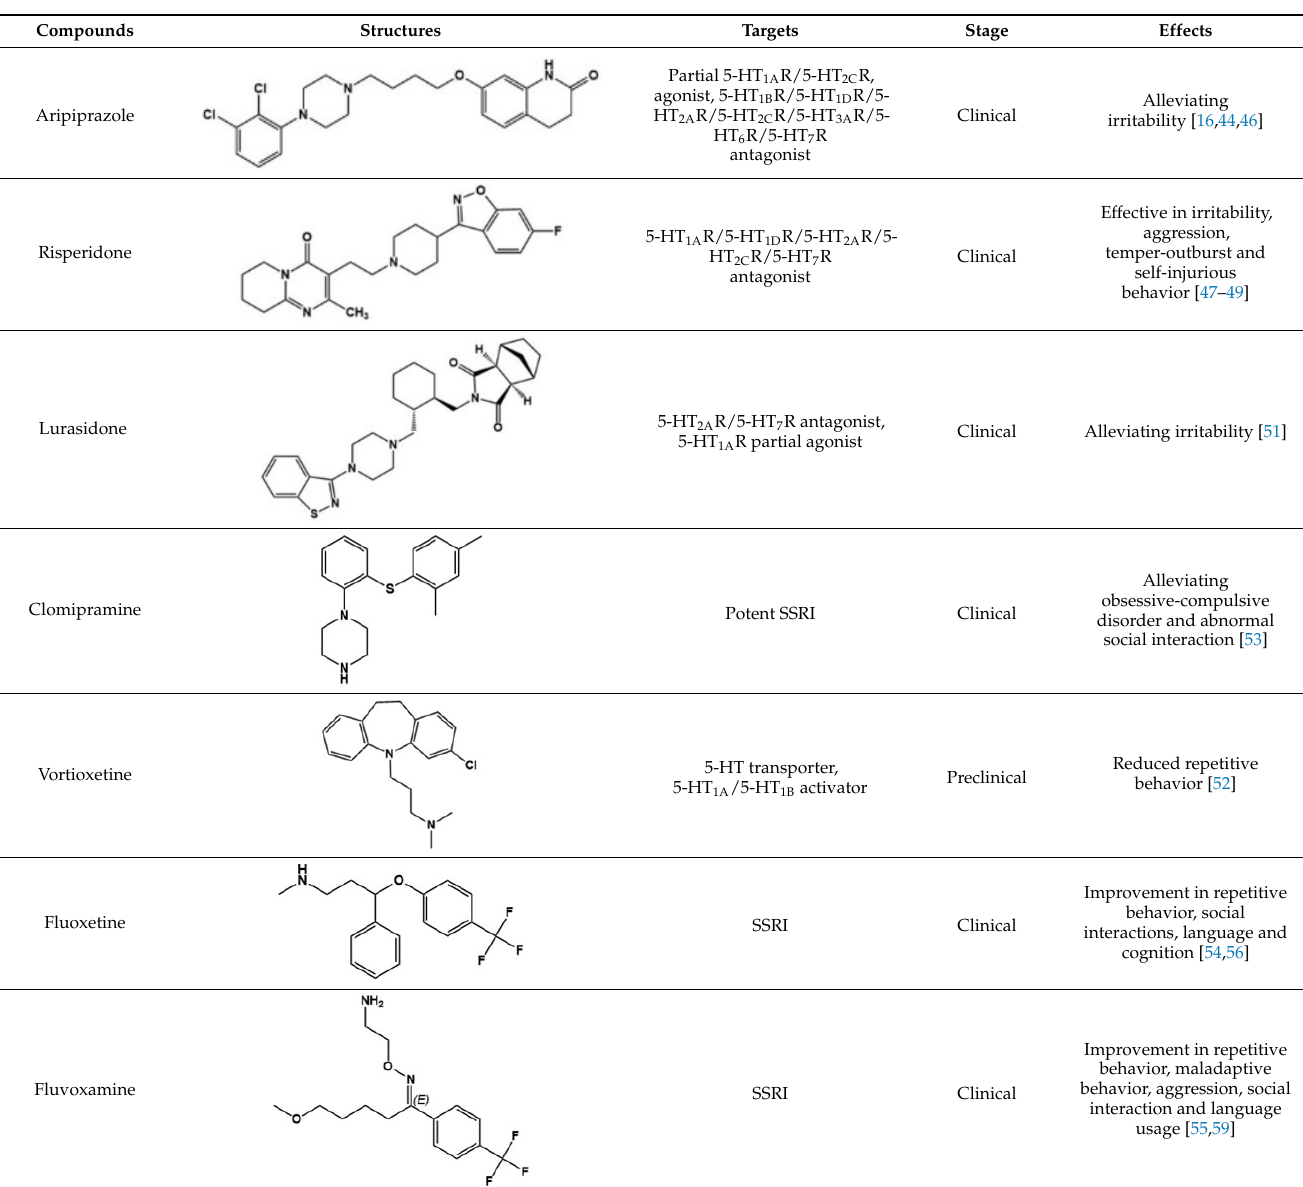
Table 1. 5-HT-related pharmacological agents and their potential effects on treating ASD symptoms. 5-HT: serotonin (5-hydroxytryptamine), 5-HTRs: 5-HT receptors. SSRI: selective serotonin reuptake inhibitor.